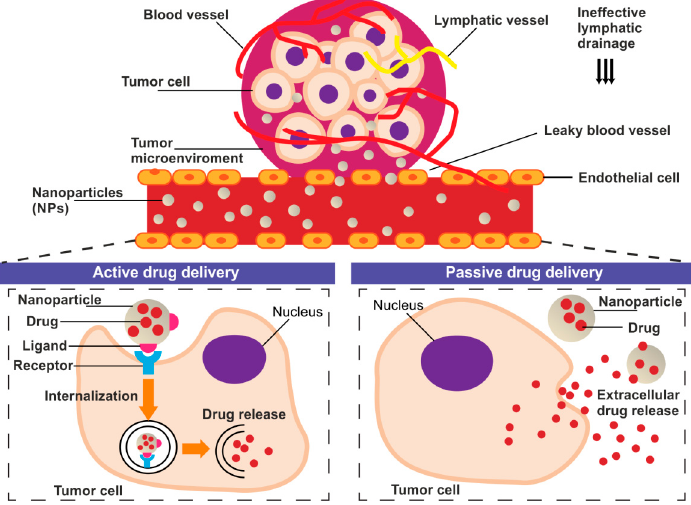
Figure 1. The schematic representation of the basic concept of the active and passive drug delivery systems in the tumor niche.